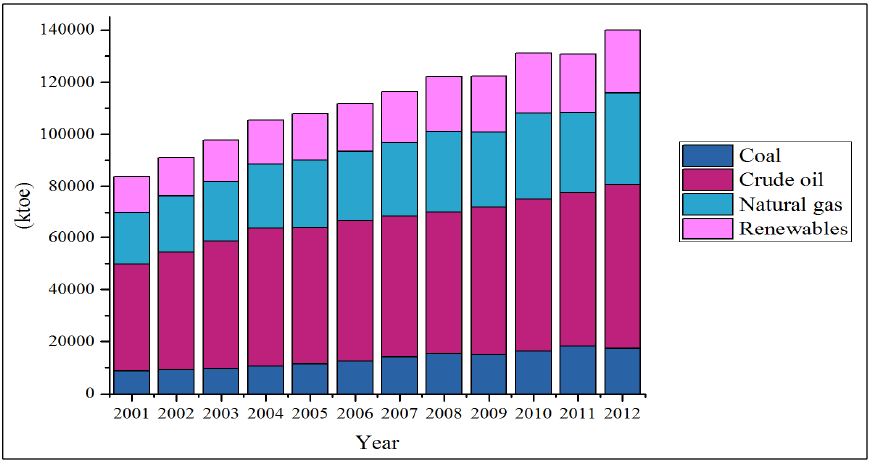
Figure 8. Thailand: primary energy mix.